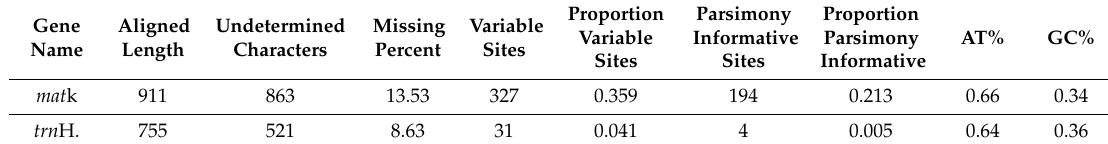
Table 4. Genetic variation estimates of DNA barcoding of the mat K and trn H genes in the eight cultivars of M. sativa